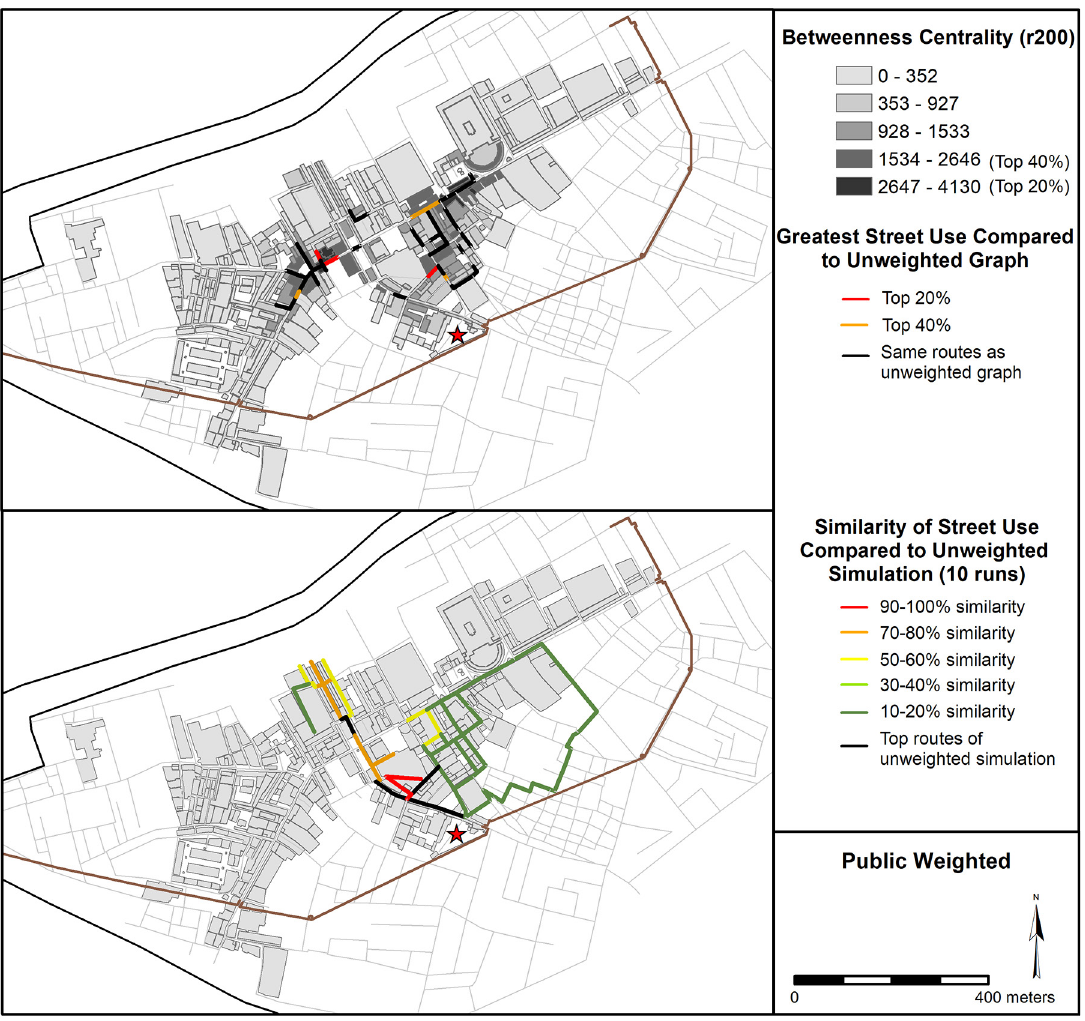
Figure 11. Top: Betweenness centrality graph weighted by public buildings. Streets displayed in red and orange follow the highest betweenness centrality metrics which are different from the unweighted graph. Bottom: Similarity of street usage by processional runs weighted by public